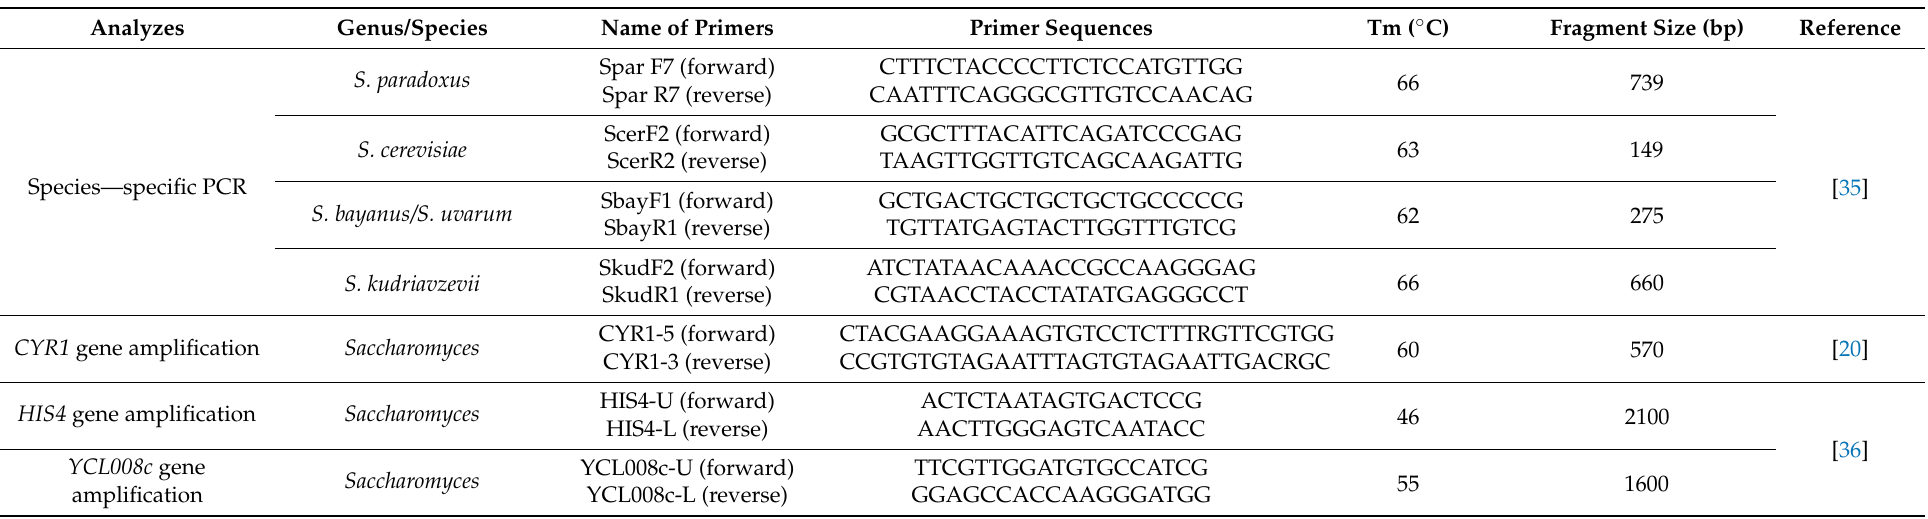
Table 2. Sequences of applied primer pairs, annealing temperature and fragment size of amplified